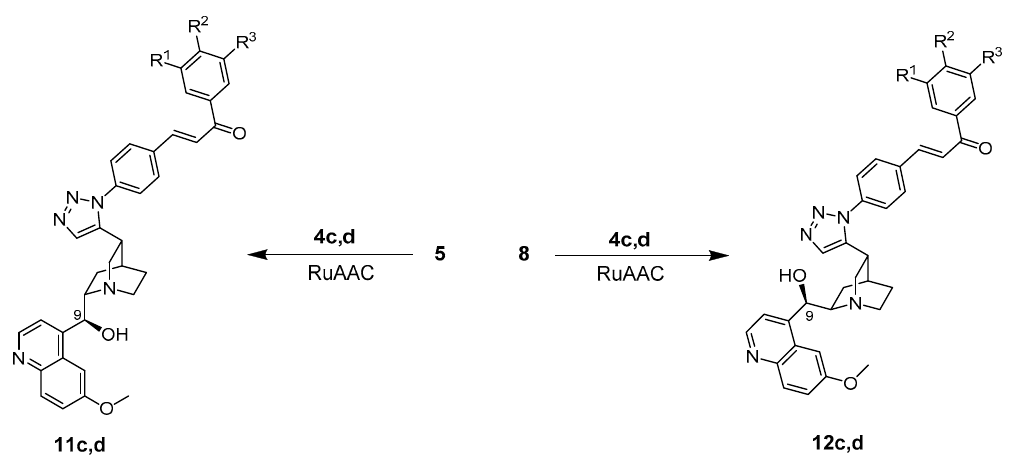
Scheme 3. Synthesis of cinchona-chalcone hybrids with the 1,5-disubstituted 1,2,3-triazole linker.